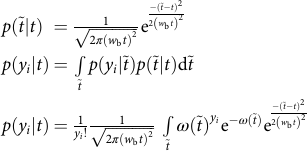
1200 ms), a Weber fraction of 0.1 was used to generate 10,000 t m values for each of these. A distribution of root-mean squared errors (RMSE) was computed in 1000 repeated runs of this process.